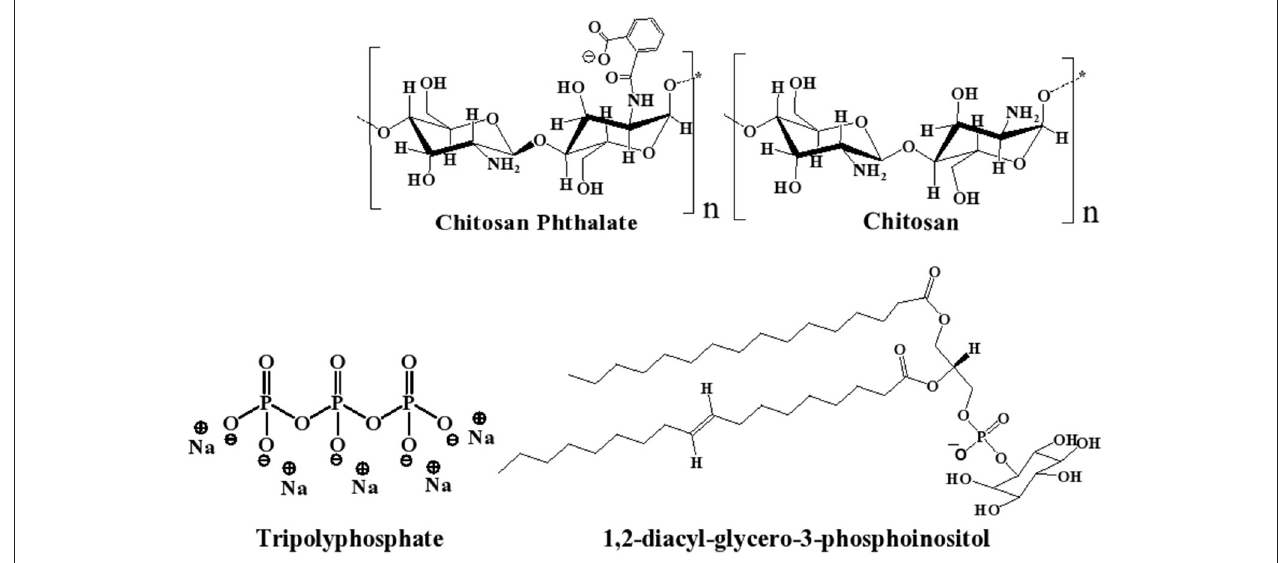
FIGURE 1 | Chemical structures of chitosan (CS), chitosan-phthalate (CSP), diacylphospho-inositol (major component of lecithin), and tripolyphosphate (TPP).